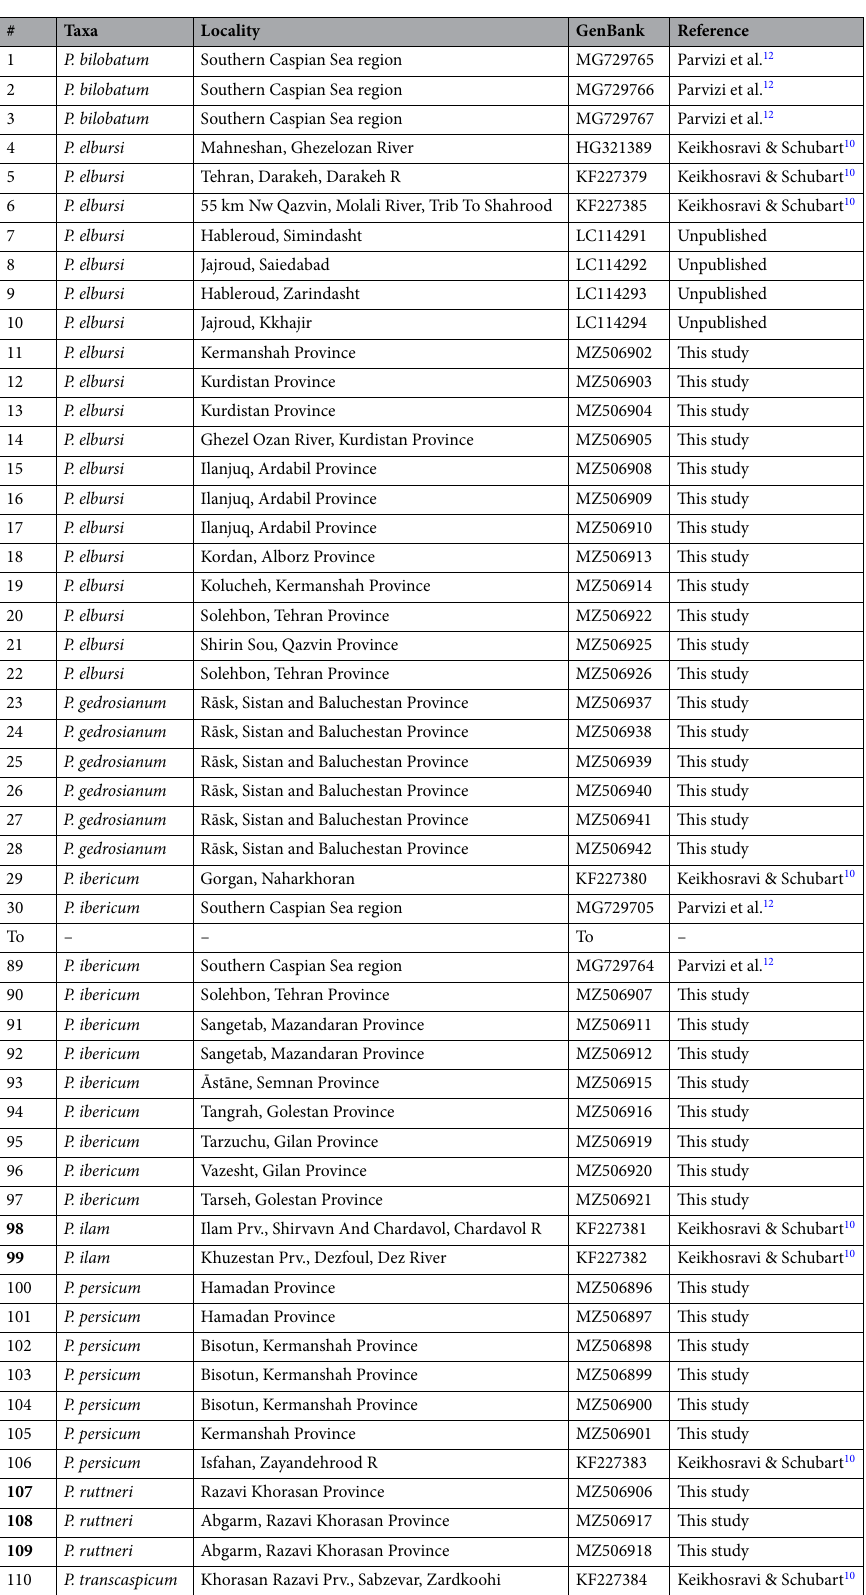
Table 1. The list of the samples used in this study. GenBank stands for NCBI’s GenBank accession numbers. For the exact distribution of the samples and their GPS coordinates, see the supplementary